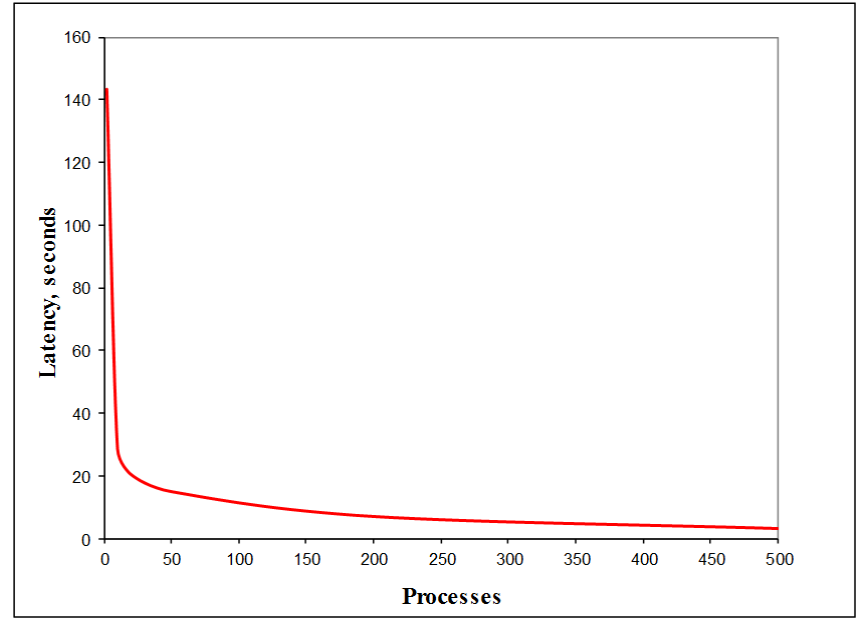
Figure 10. The latency rate with different number of processes .